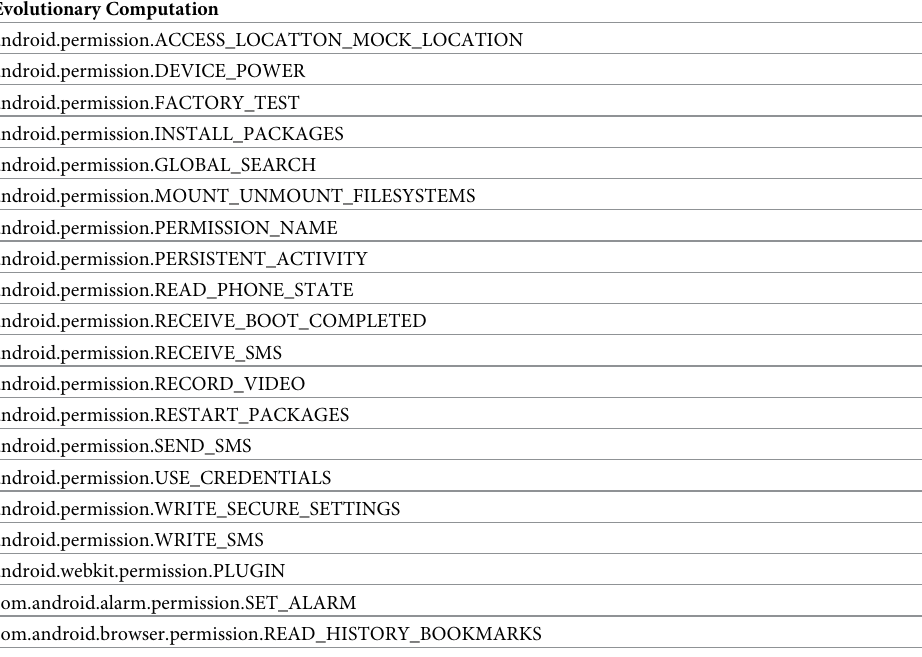
Table 8. 20 features selection of evolutionary